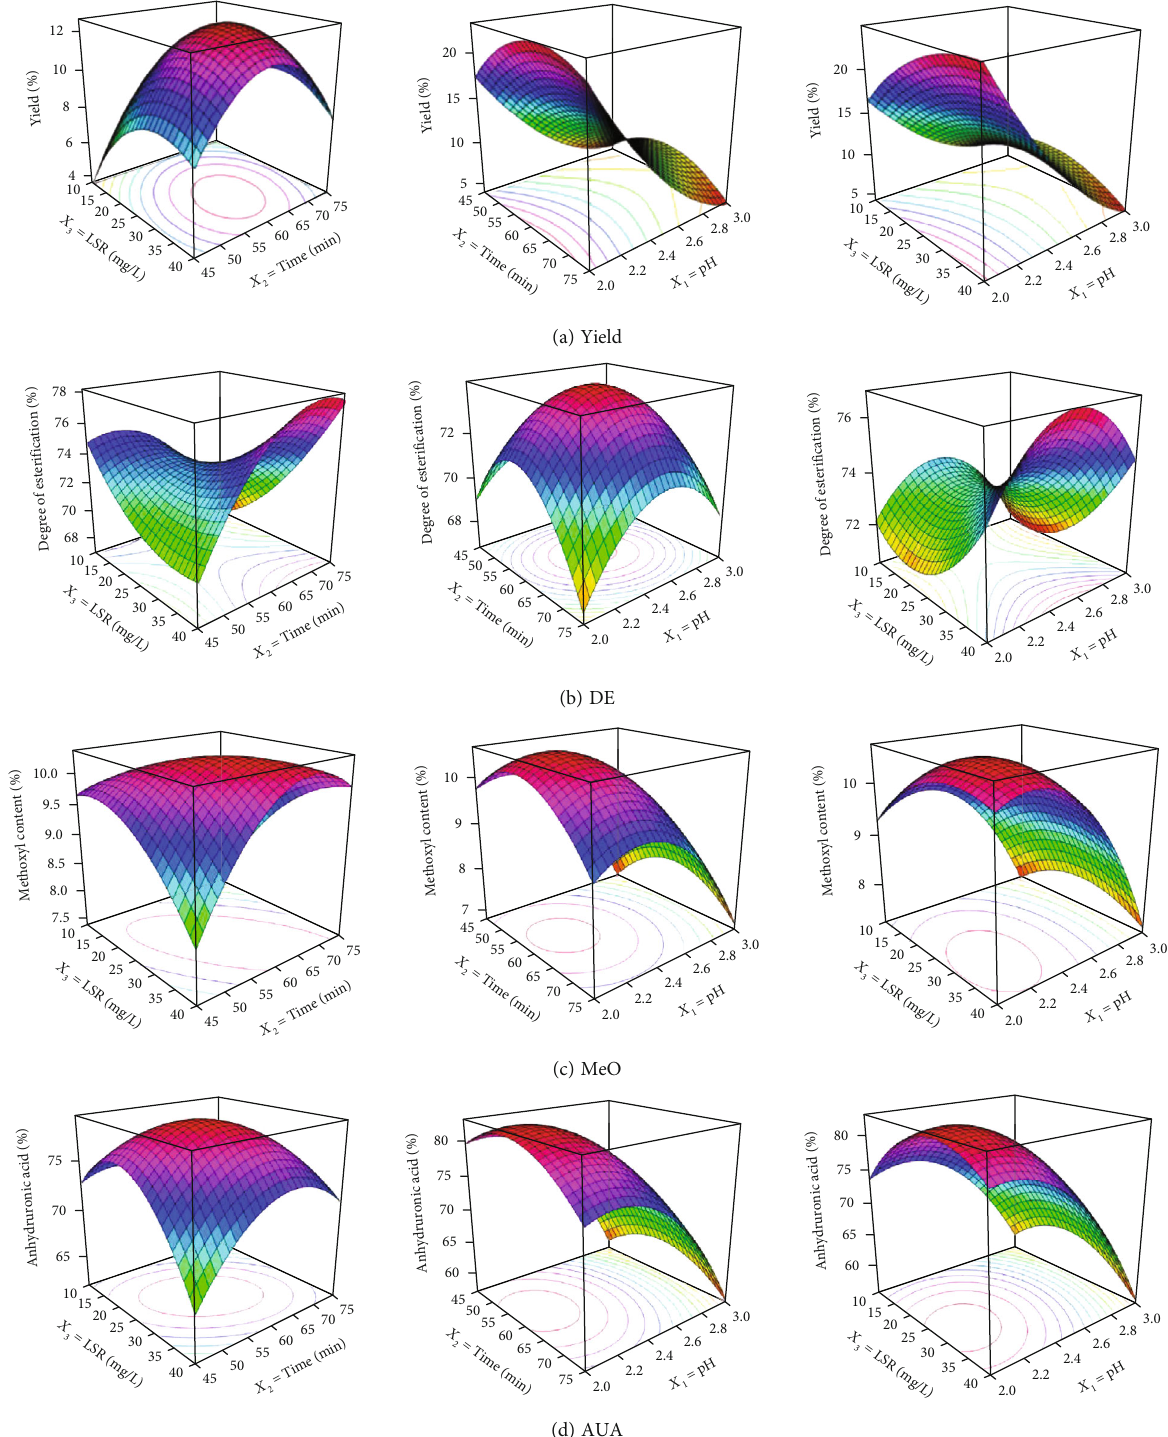
Figure 1: Response surface showing the e ff ect of dependent variables (pH, time extraction, and LSR) on the pectin yield (a), DE (b), MeO (c), and AUA